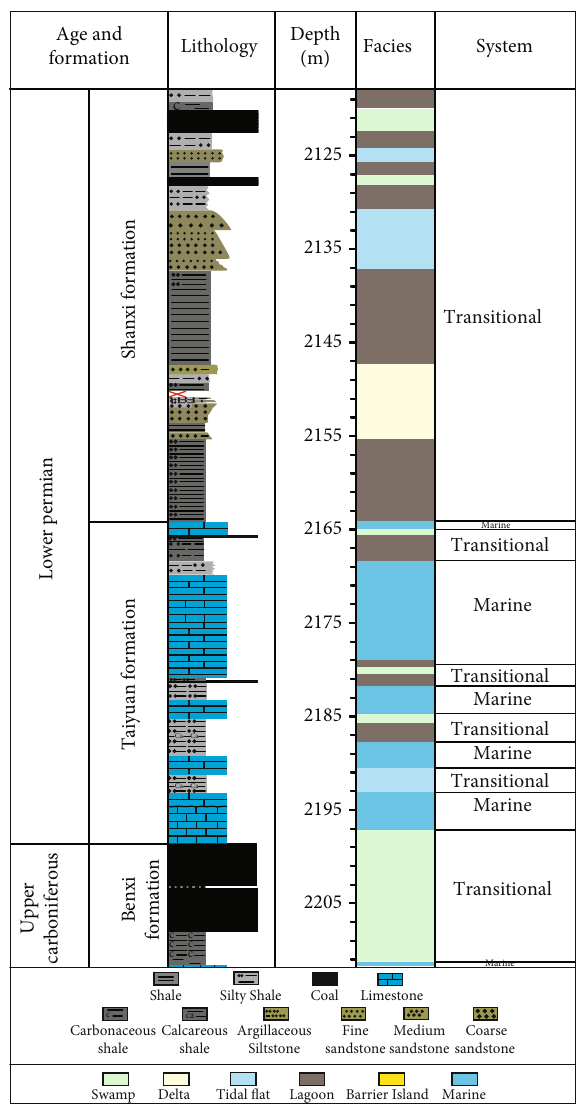
Figure 2: Stratigraphic column and sedimentary environment of the Carboniferous-Permian marine-nonmarine transitional strata (modi fi ed from